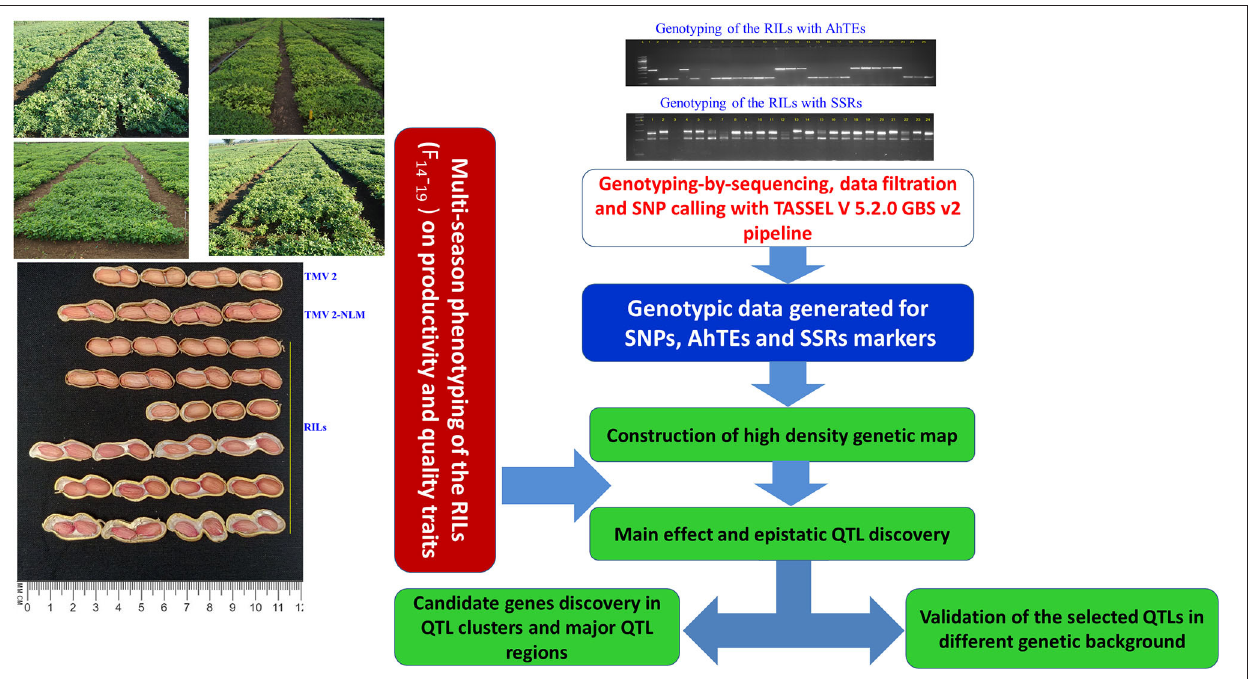
FIGURE 1 | Flow chart of genotyping, high density genetic map construction, multi-season phenotyping, identification of genomic regions for productivity, and quality traits and their validation.